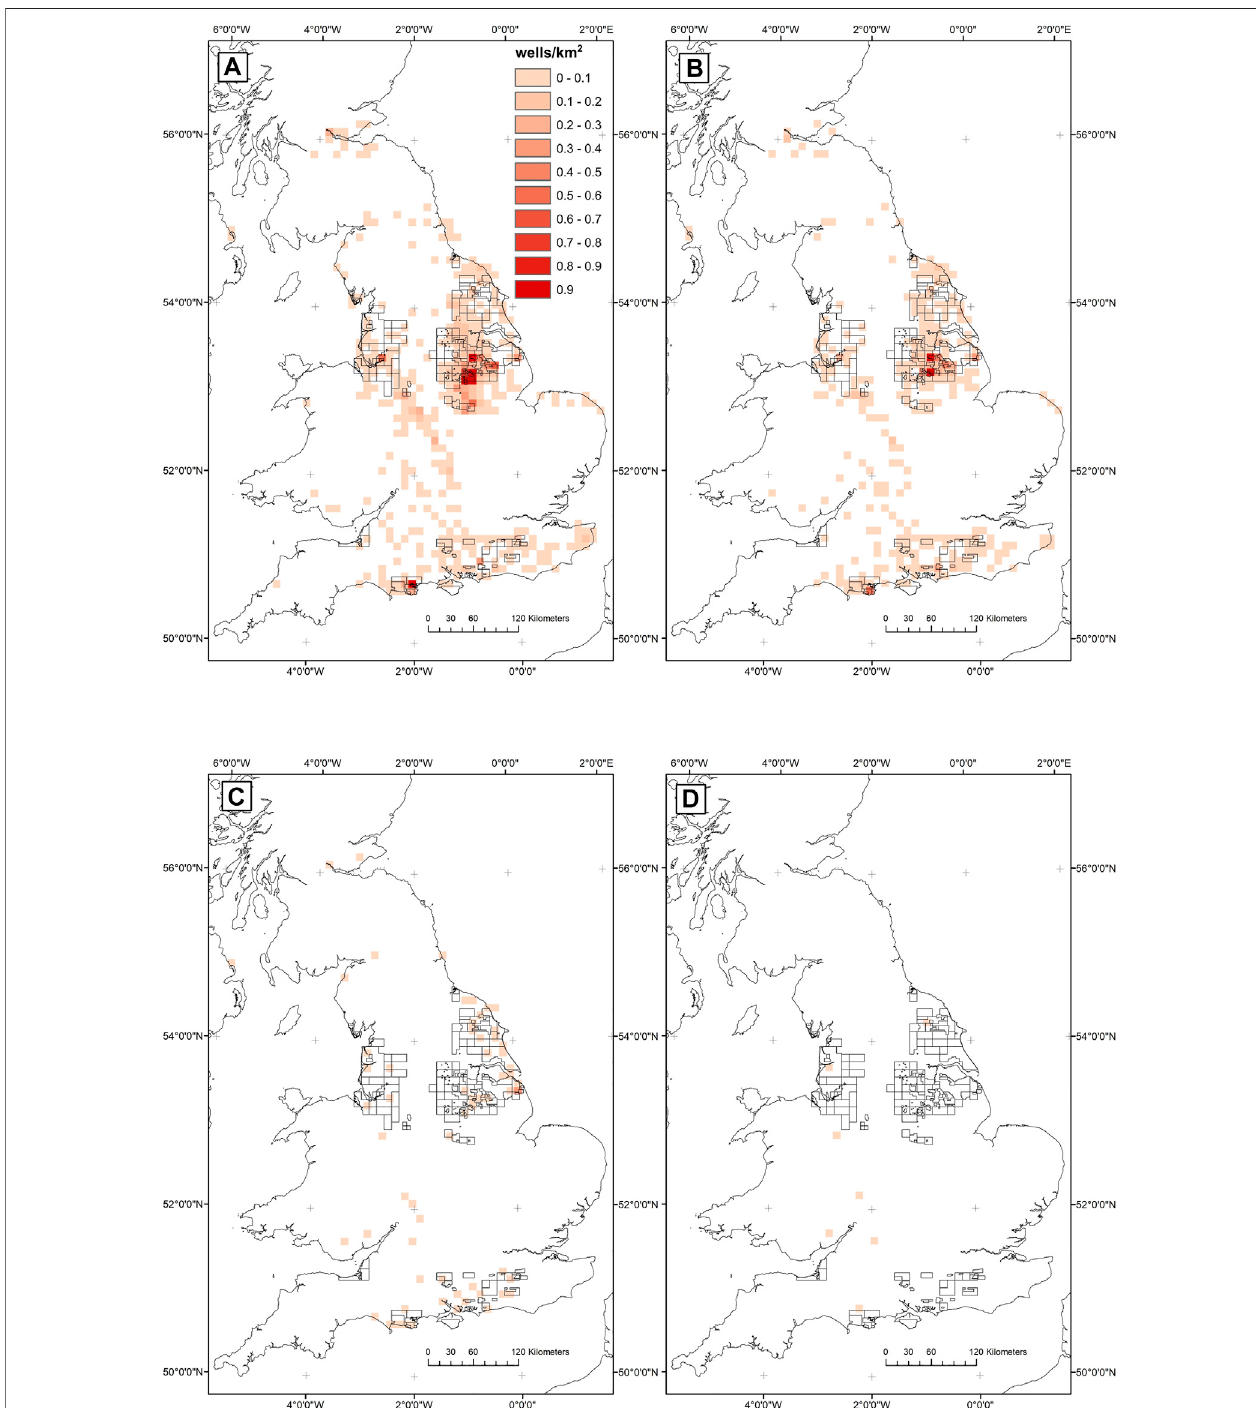
FIGURE4| MapshowingthedensityofboreholesfromUKOGLdatabasewithtotaldepths(TVD)of: (A) greaterthan500 m; (B) greaterthan1 km; (C) greaterthan 2 km; (D) greater than 3 km. Includes location of current PEDL.